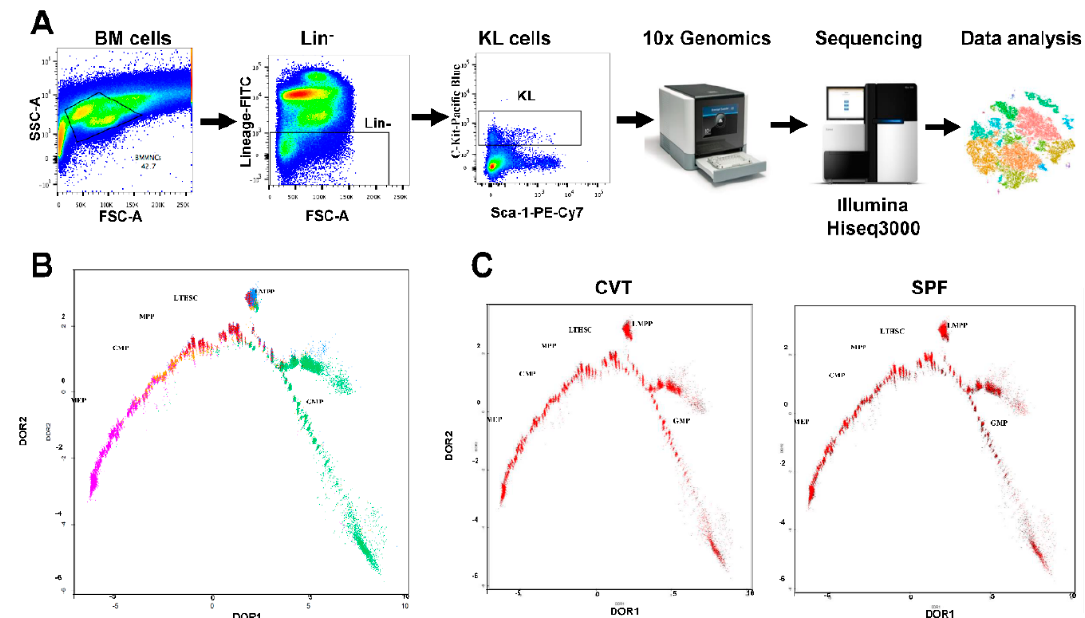
Figure A1. ( A ) Revelation of differential gene expression in Lin − Kit + (KL) cells from CVT and SPF mice by single-cell RNA-seq. BM cells from 8 CVT and 8 SPF mice were sorted into KL cells, pooled to form 4 cell pools for each housing condition, and analyzed by single-cell RNA-seq. Illustration of cell sorting, genomics, sequencing and data analyses. ( B ) Gene expression defines KL cells into various subsets: LTHSC, long-term hematopoietic stem cells; MPP, Multipotent progenitors; CMP, common myeloid progenitors; MEP, megakaryocytic-erythroid progenitors; GMP, granulocyte-monocyte progenitors; LMPP, lymphoid-primed multipotent progenitors. ( C ) Hematopoietic cell subsets distribution in KL cells from CVT and SPF mice based on single cell RNA-seq.